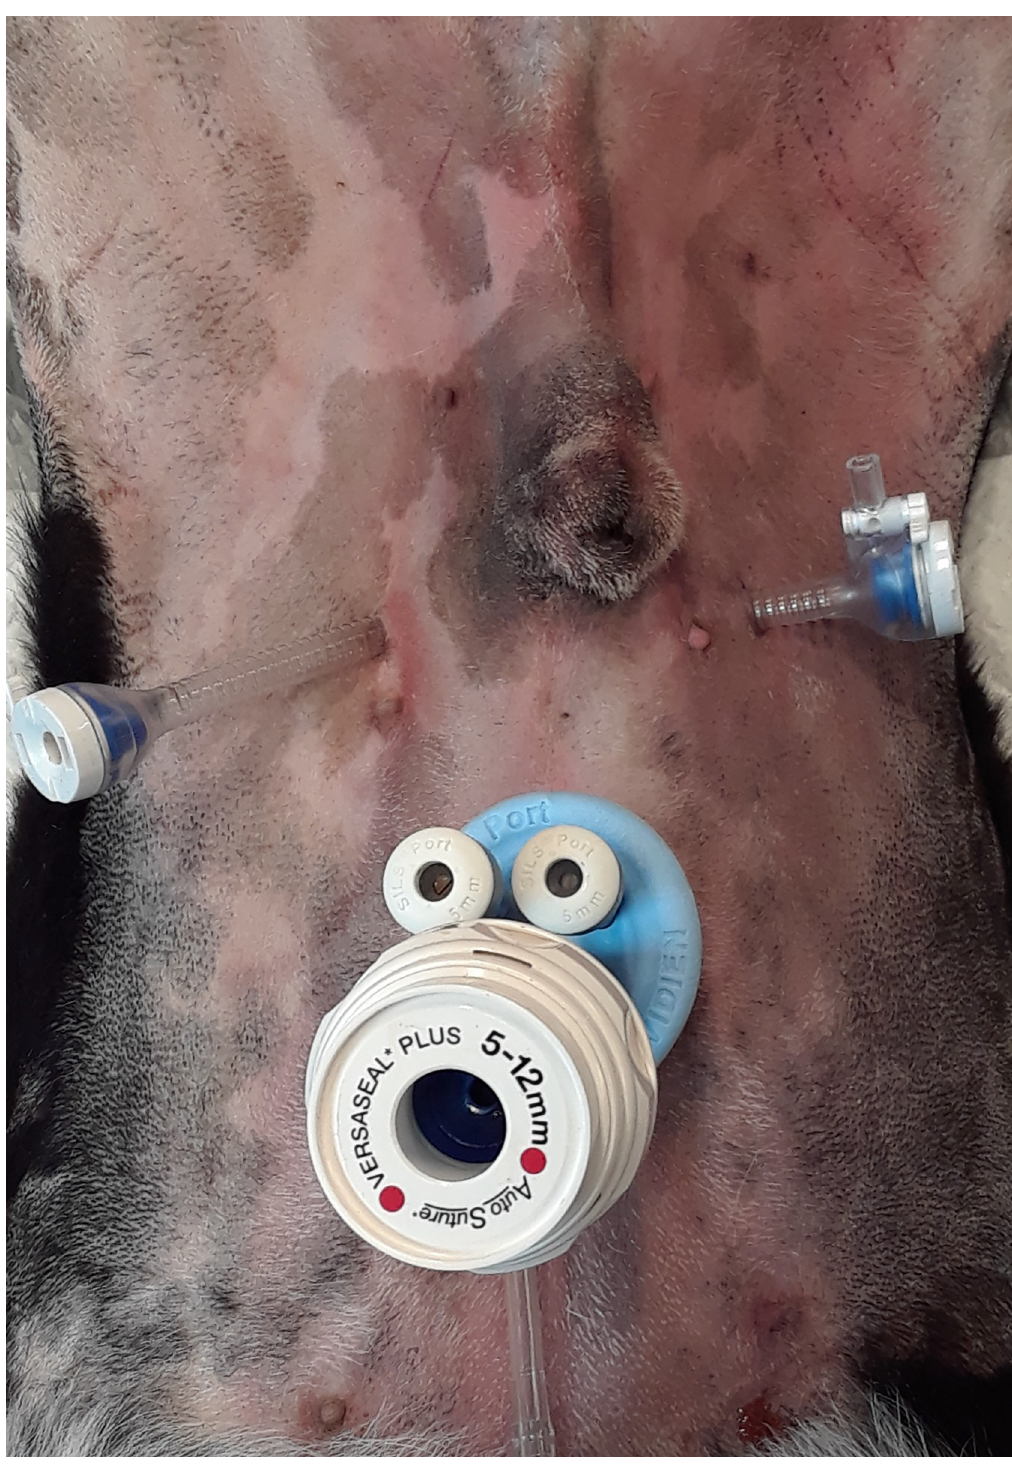
Fig 2. Outside view showing the placement of the single access port and the two 5 mm cannula on the left and right sides of the abdominal cavity.